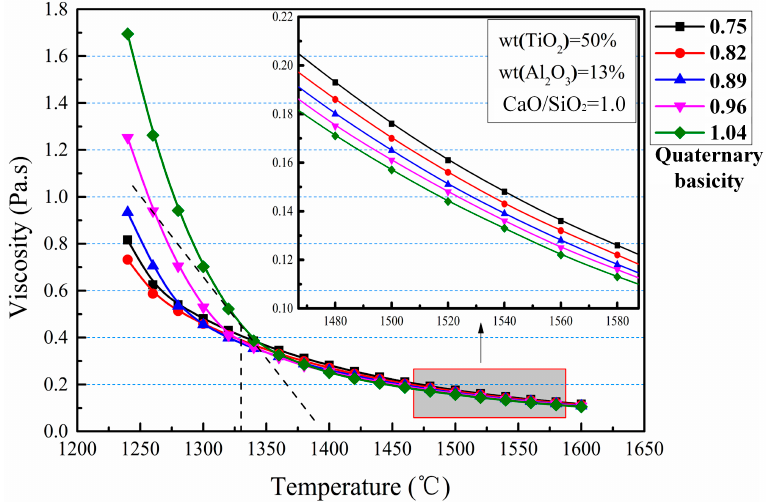
Figure 6. Effects of quaternary basicity by addition of MgO on titanium slag viscosity (FactSage 7.0).